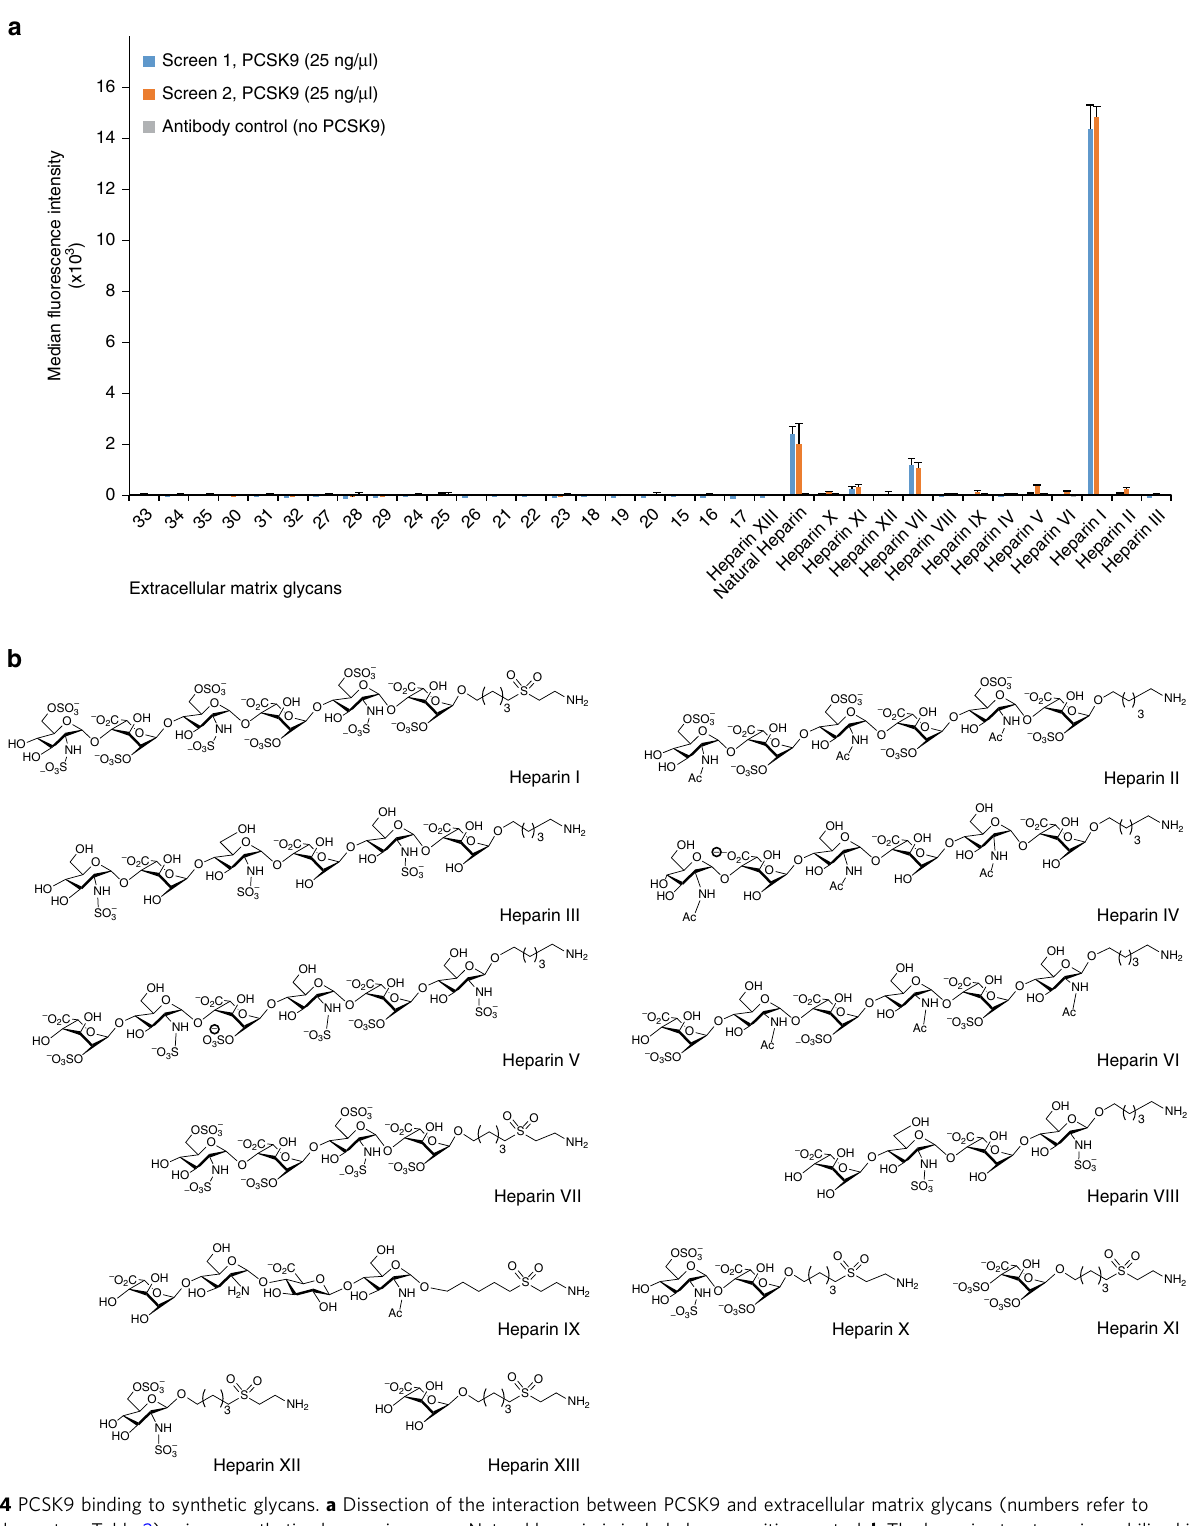
Fig. 4 PCSK9 binding to synthetic glycans. a Dissection of the interaction between PCSK9 and extracellular matrix glycans (numbers refer to Supplementary Table 2) using a synthetic glycan microarray. Natural heparin is included as a positive control. b The heparin structures immobilized in the glycan microarray are shown. Structures interacting with PCSK9 contain repeats of [4)- α -GlcN-6,N-disulfate(1 → 4)- α -IdoA-2-sulfate-(1 →